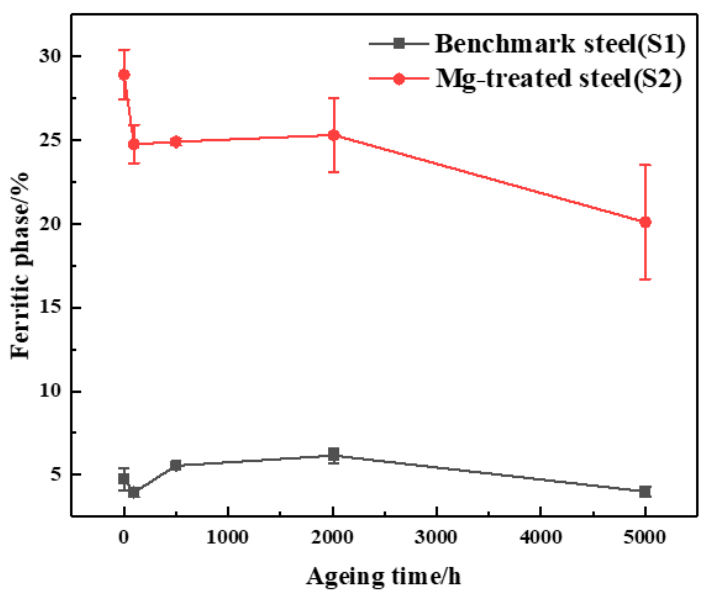
Figure 7. Ferritic phase content of S1 and S2 samples aging at 580 °C for different time.